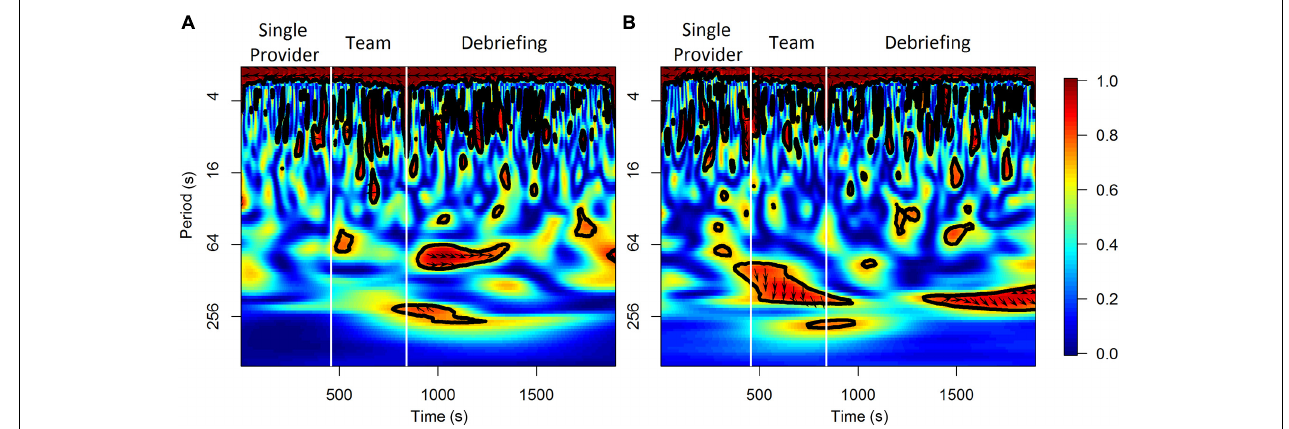
FIGURE 2 | An illustrative example of the results of WTC analysis for HbO (A) and HbR (B) from a scenario